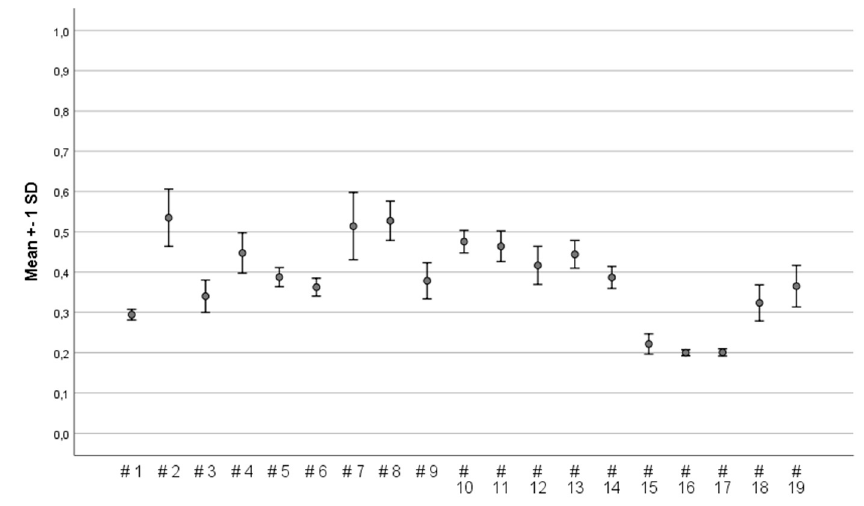
Figure 6. Results of DCOF for the 19 anti-slip devices. Scale 0–1.00. Table 3. Results of pedestrian gait speed and ratings of gait qualities during a walk on the indoor test track the with plain ice surface with 19 anti-slip devices. Values are median (min-max). Ice Uncovered